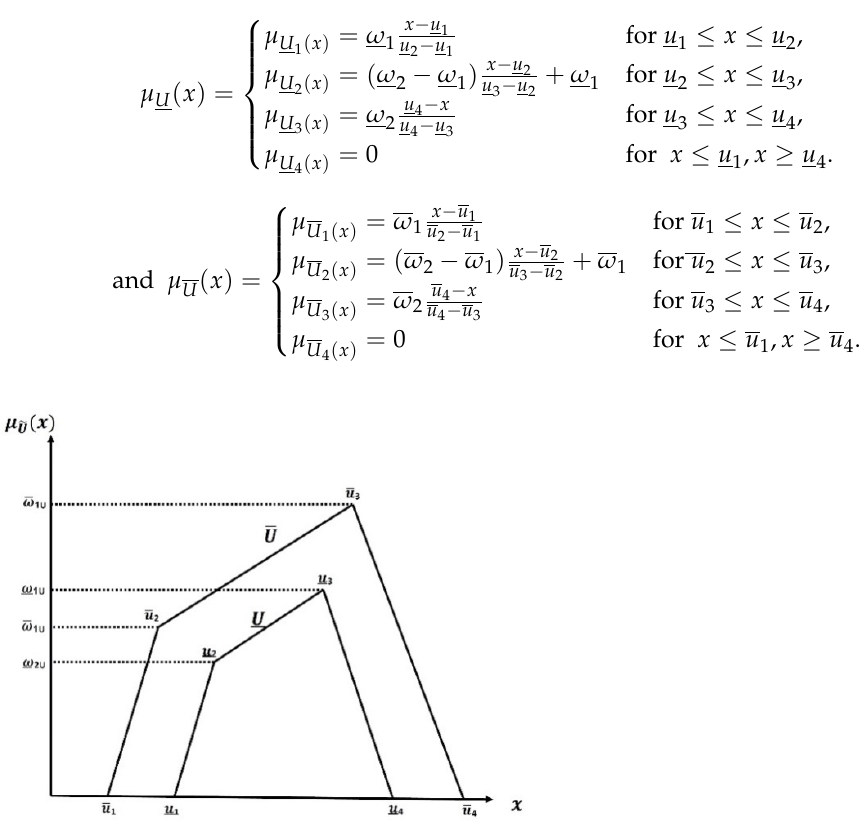
Figure 4. Representation of GIT2TrFN.